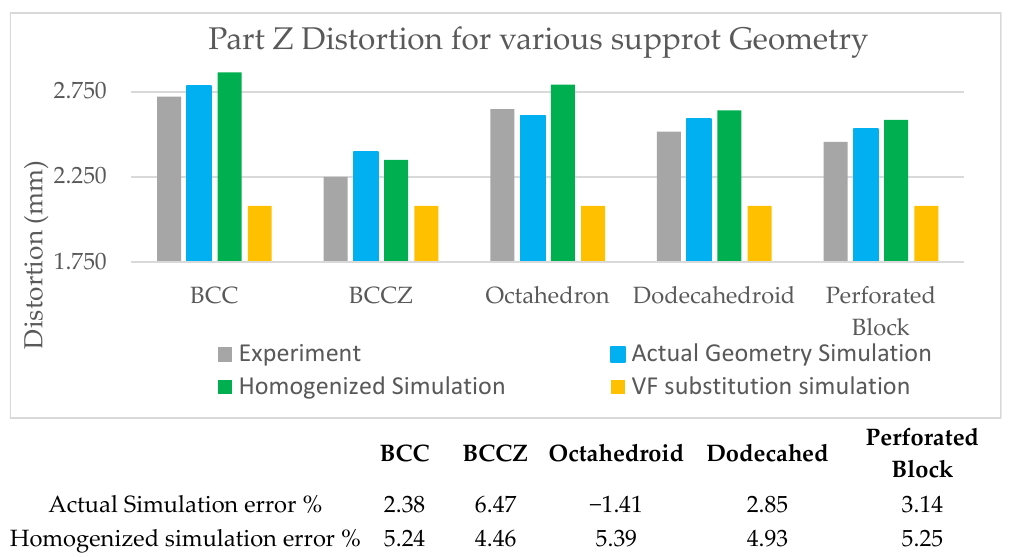
Figure 15. Cantilever part distortion comparison—Experimental versus Simulation results.